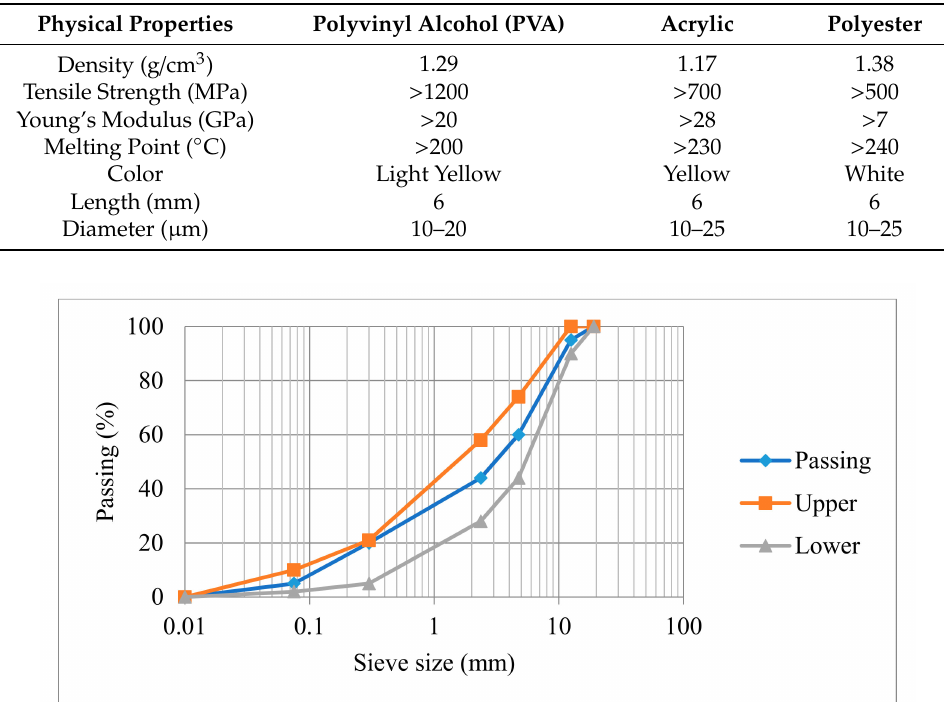
Figure 1. The synthetic fibers: ( a ) Polyvinyl alcohol fiber (PVA); ( b ) Acrylic fiber; ( c ) Polyester fiber. Table 3. The physical and mechanical properties of the synthetic fibers.